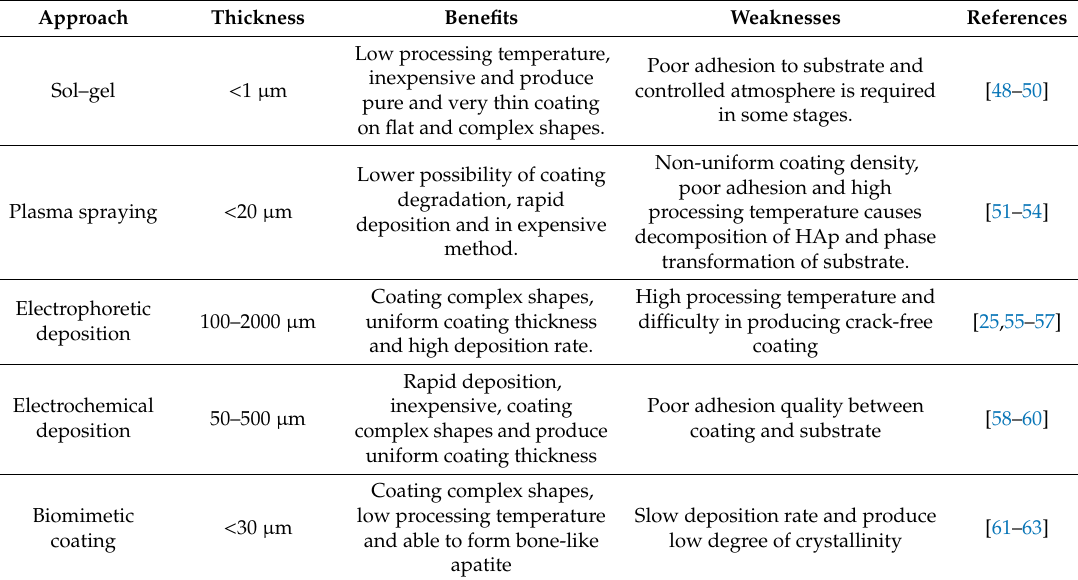
Table 2. Di ff erent deposition techniques of HAp